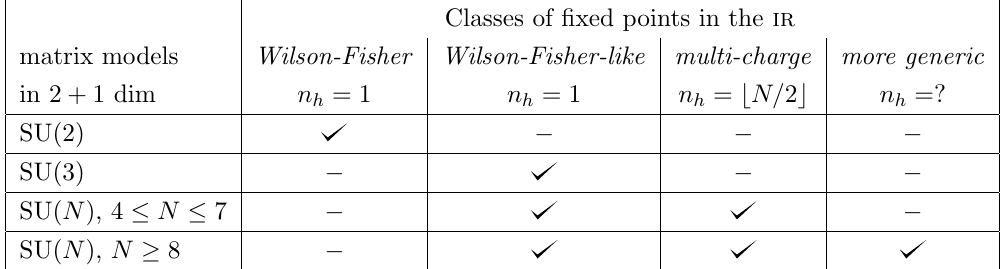
Table 1 . The table presents the qualitatively distinct classes of (cid:12)xed points that appear in adjoint models. The last column refers to additional (cid:12)xed points with possibly di(cid:11)erent behavior not classi(cid:12)ed in this work. For a given N , a hyphen means that this type of (cid:12)xed point cannot appear. n h gives the number of independent U(1) scales admissible in the non-linear e(cid:11)ective theory. su ( N ) denotes the time-independent where (cid:8) 0 2